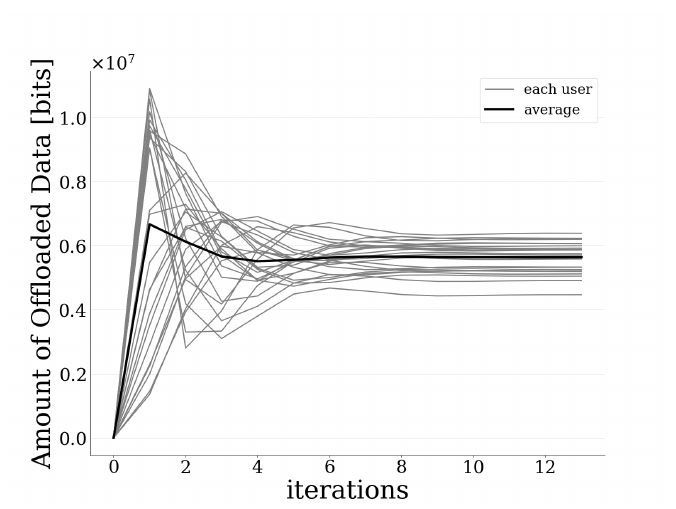
Figure 3. Amount of data offloaded by each user vs. iterations.